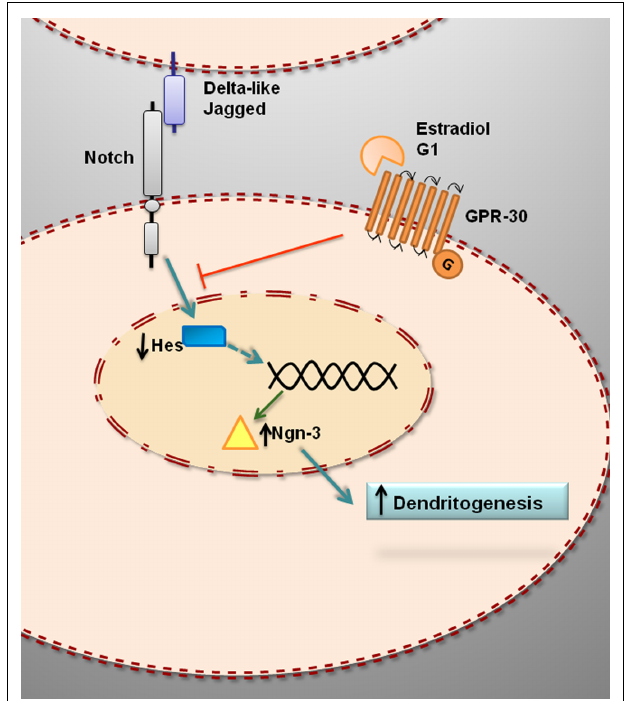
FIGURE 2 | Hypothetical model for the estrogenic regulation of Ngn3 and dendritogenesis in primary hippocampal neurons. Estradiol downregulates Hes genes and upregulates Ngn3, which in turn promotes dendritogenesis.The effect of estradiol is not imitated by ER α or ER β agonists and it is not blocked by ER α or ER β antagonists. In contrast, G1, agonist of the putative membrane estrogen receptor GPR30, imitate the effect of estradiol on Ngn3 expression and dendritogenesis, suggesting that the action of estradiol is mediated by GPR30.